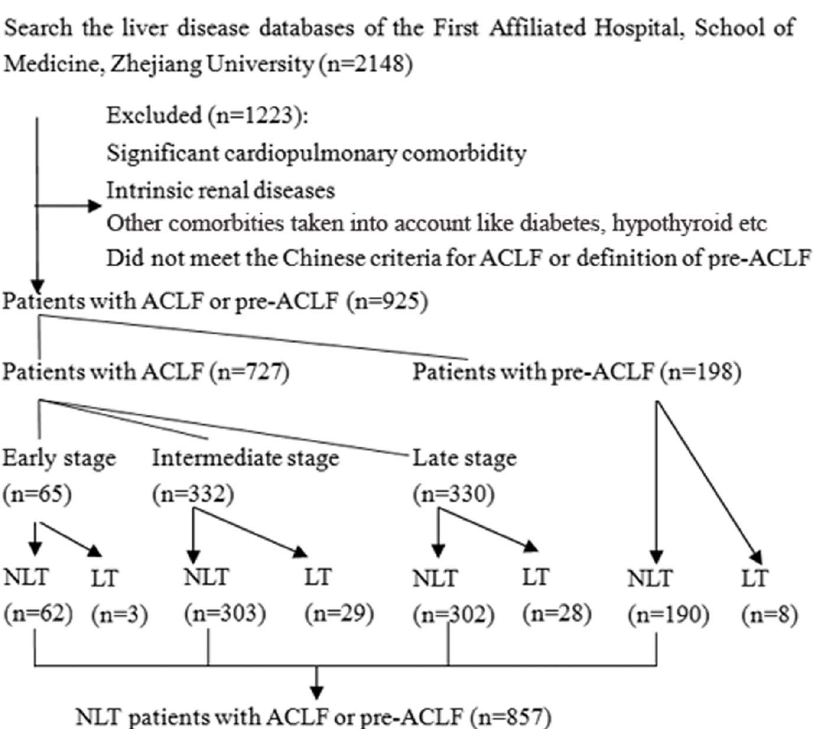
Figure 1. Flowchart of the study group selection process. LT: patients underwent liver transplantation; NLT: patients without liver transplantation.